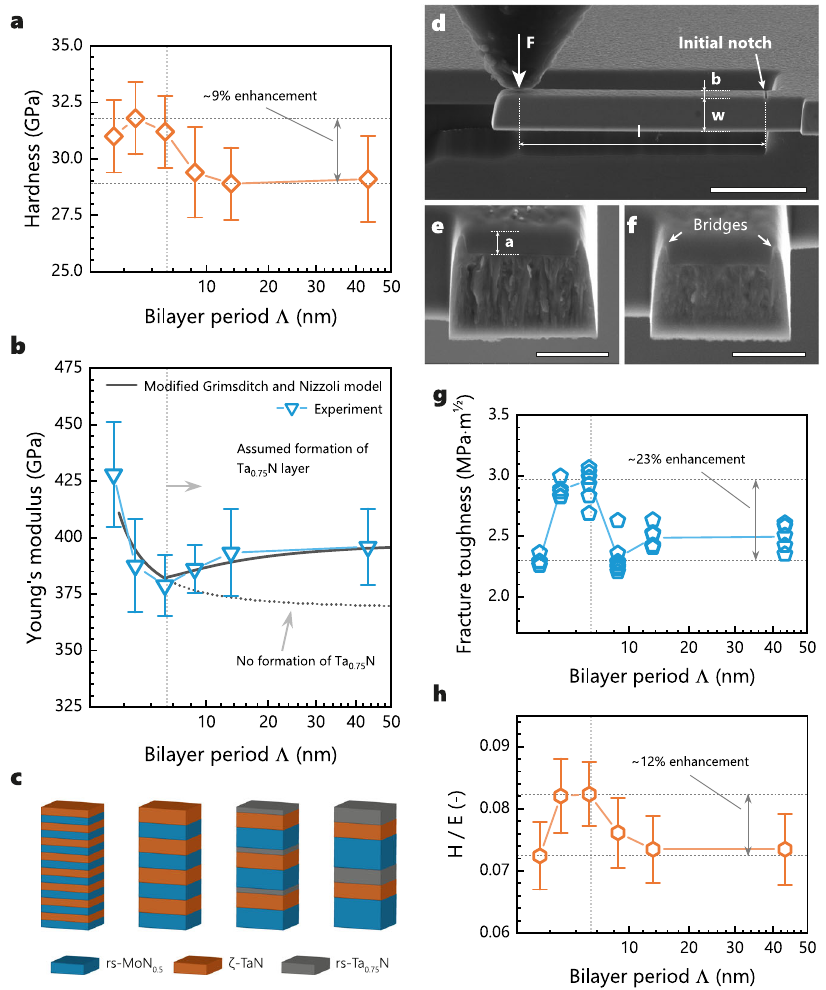
Fig. 6 The mechanical properties of MoN – TaN superlattice thin fi lms. The hardness as a function of the bilayer period is shown in ( a ). The vertical dashed line indicates the bilayer period where we assume the formation of a second phase in the TaN layer. Young ’ s modulus over Λ is shown in ( b ). Here, besides the computational Young ’ s modulus (Grimsditch and Nizzoli) including a second phase in TaN, we also plotted the one without it. The sketch in ( c ) shows the proposed coating architecture. The SEM micrograph ( d ) shows a cantilever before micromechanical testing in a 10° inclined view including the dimensions of the lever arm l , cantilever width b , cantilever height w , the initial notch, and the point of application of force. The fracture cross sections in ( e ) (1.5 nm) and (f) (8.3 nm) show the depth of the initial notch a ; exemplary marked are the thin bridges necessary for our micromechanical tests. The plots ( g ) and ( h ) show the derived fracture toughness K IC and the empirical H / E toughness criteria, respectively. All mechanical properties were determined on sample deposited on Si (100), additionally, Young ’ s modulus was cross-checked by performing nanoindentation experiments also on MgO (100), sapphire, and austenitic steel. All error bars represent standard deviation. The scale bar in ( d ) is 5 µ m long, in ( e ), and ( f ) the scale bar is 1 µ m